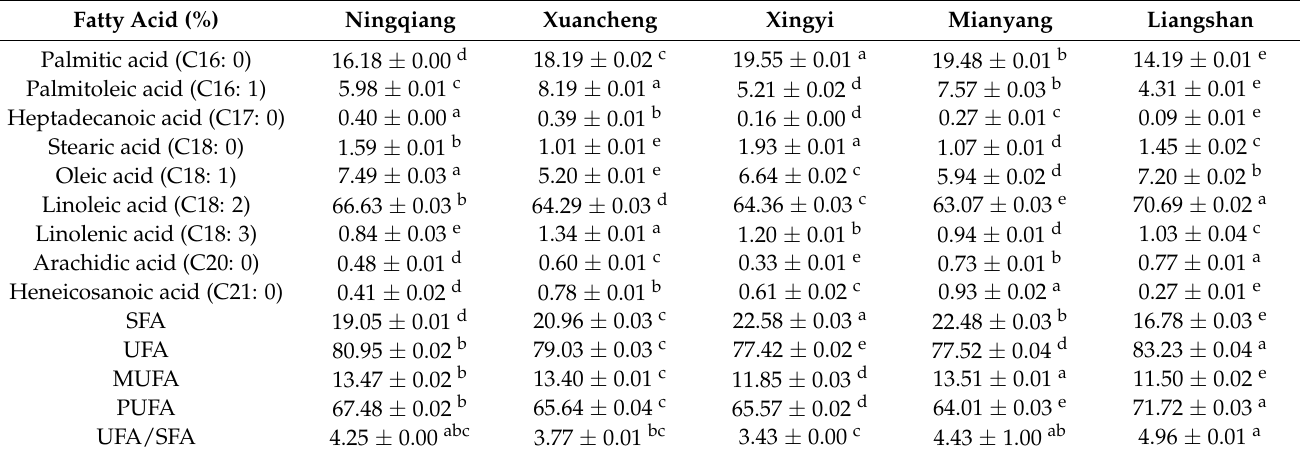
Table 2. Fatty acid composition of IPPO from five